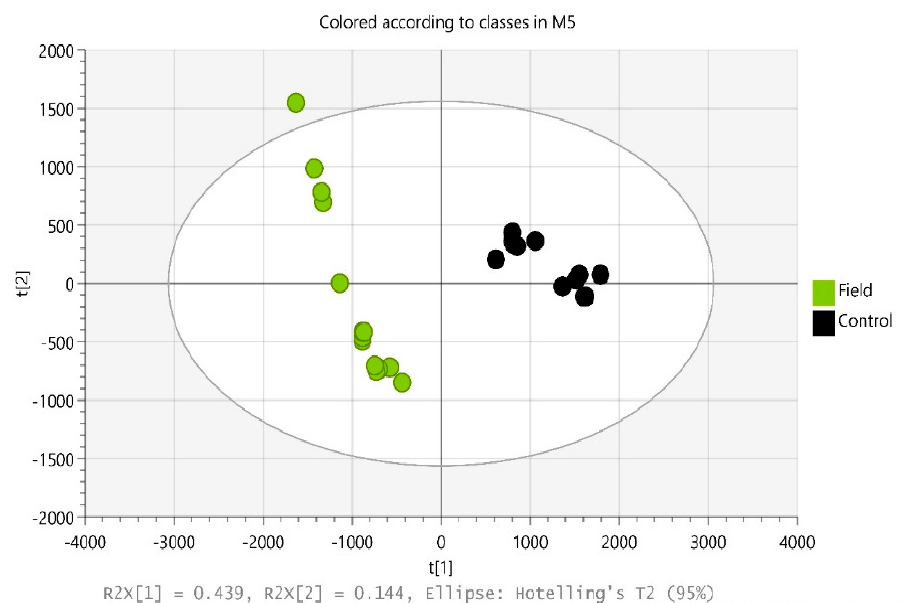
Figure 3. Partial least squares–discriminant analysis (PLS–DA) including control (not contaminated) and field (contaminated soils) using ultra-high-performance liquid chromatography (UHPLC)–Orbitrap–MS; (control is not contaminated soil located 1km away from the accident site, field is contaminated soil located from 100 m to 500 m away along the diffusion direction of gas cloud at the accident site).